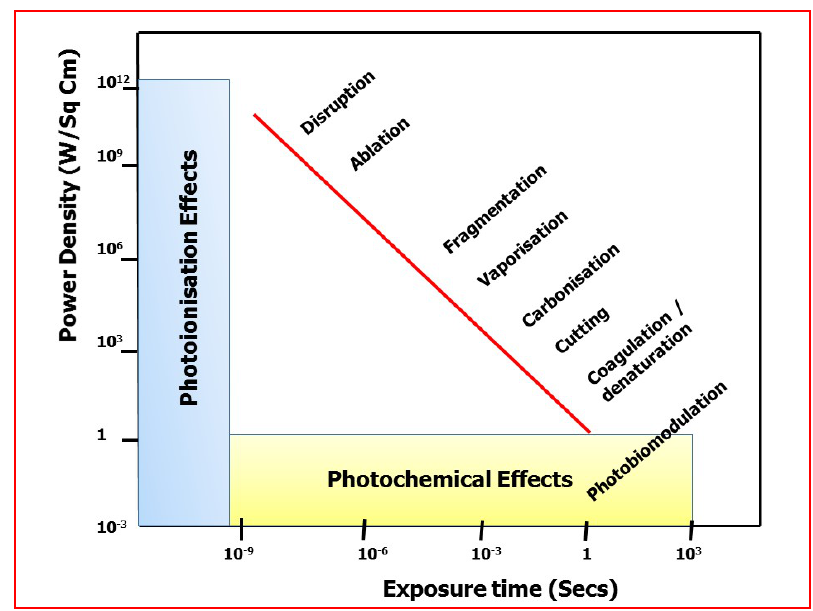
Figure 4. Relationship between incident photonic power density and exposure time (seconds). Changes